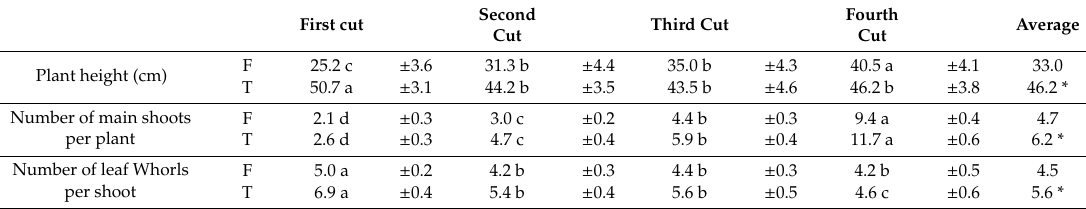
Table 2. Developmental traits.